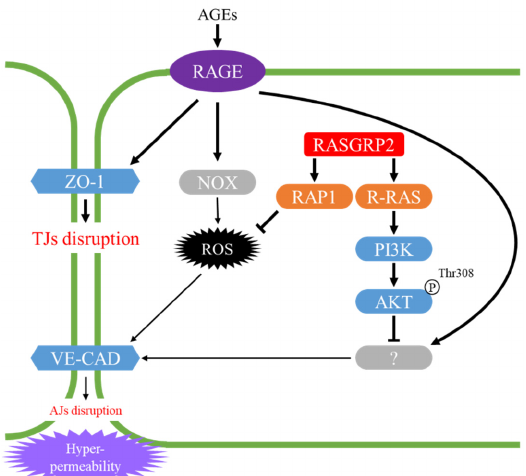
Figure 4. Proposed model for vascular hyper-permeability suppression via the RAP1 and R-RAS pathways by RASGRP2. AGEs: advanced glycation end products, RAGE: receptor for AGEs, ZO-1: zonula occludens-1, VE-CAD: vascular endothelial-cadherin, TJs: tight junctions, AJs: adherens junctions.